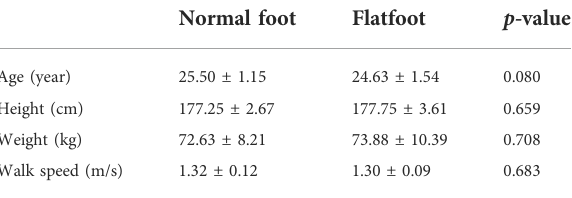
TABLE 1 Baseline data of subjects ( n = 32, (cid:1) x ± s).